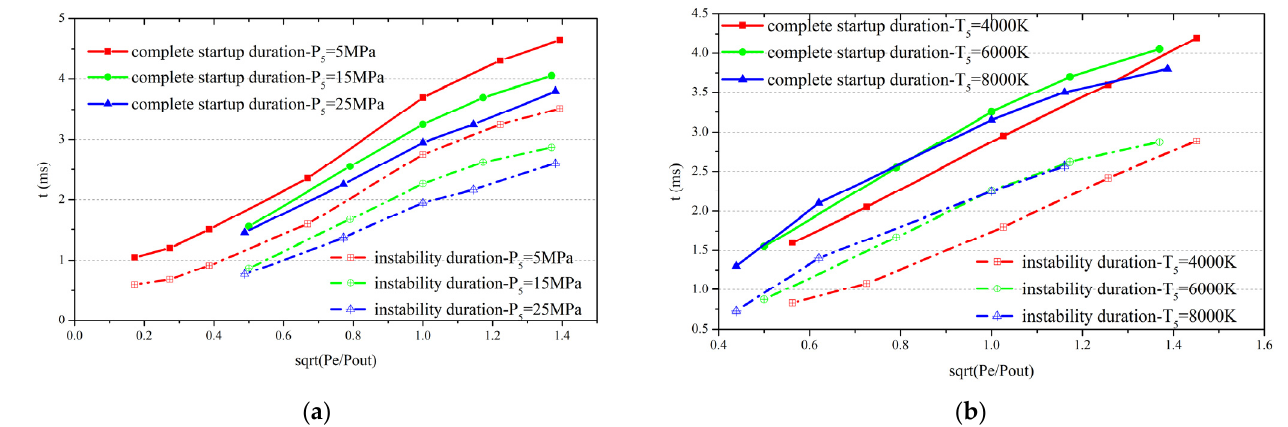
Figure 15. Nozzle starting parameters for different chamber conditions. ( a ) T 5 = 6000 K, ( b ) P 5 = 15 MPa.